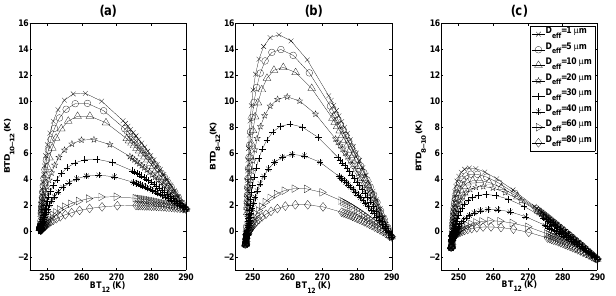
Figure 2. Brightness temperatures differences (BTD) as a func- tion of the 12.05µm brightness temperature (BT 12 ) for eight ef- fective diameters ( D eff ) and different optical thickness between 0 and 50 at 12.05µm: (a) BTD 10 − 12 between 10.60 and 12.05µm channels, (b) BTD 8 − 12 between 8.65 and 12.05µm channels and (c) BTD 8 − 10 between 8.65 and 10.60µm channels.